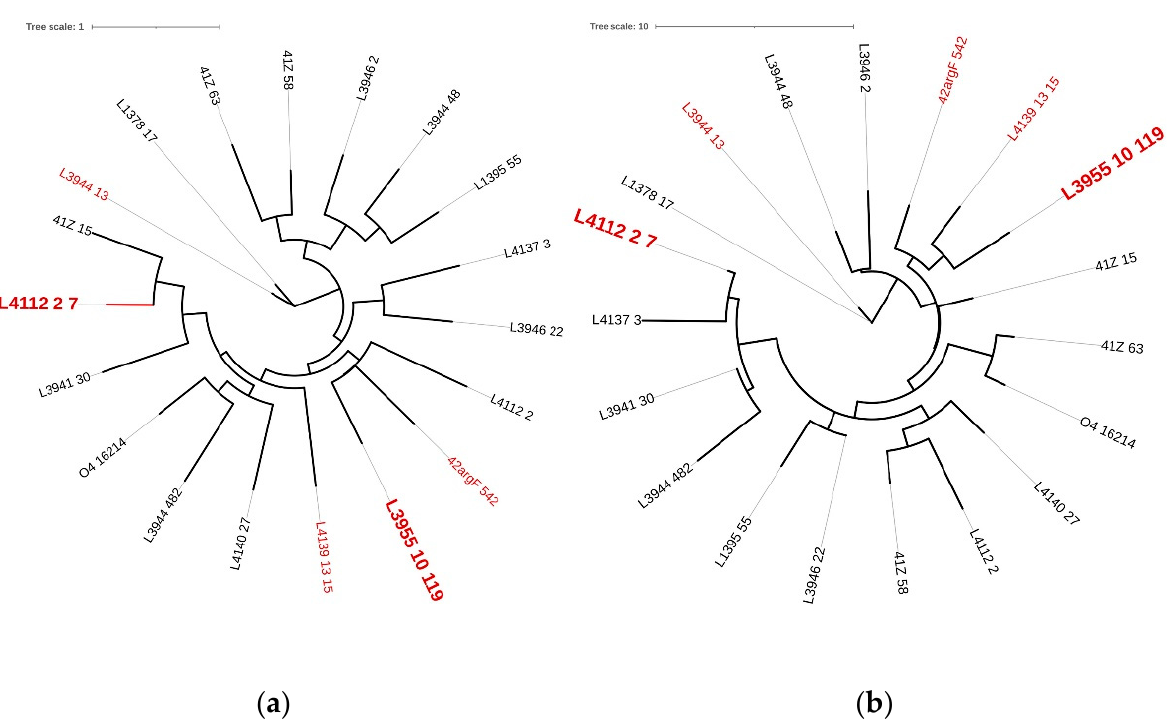
Figure 2. Phylogenetic trees of prophage lysins based on ( a ) nucleotides and ( b ) amino acids se- quences. Genomic tree was constructed using the Jukes–Cantor substitution model and no boot- strapping/likelihood as branch support method and the proteomic tree was constructed using the Le Gascuel substitution model and no bootstrapping/likelihood as branch support method in PHYML 3.3.20180621 (Geneious version 2021.1.1). Trees were visualized using iTOL v6 [30]. Red—endolysins selected for cloning; larger leaf names—selected for liposome